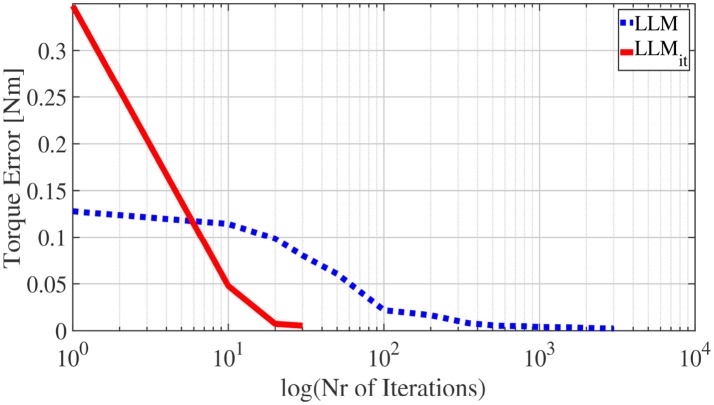
Torque RMSE for Constrained Direction Sampling with LLMit (red) and LLM (blue).